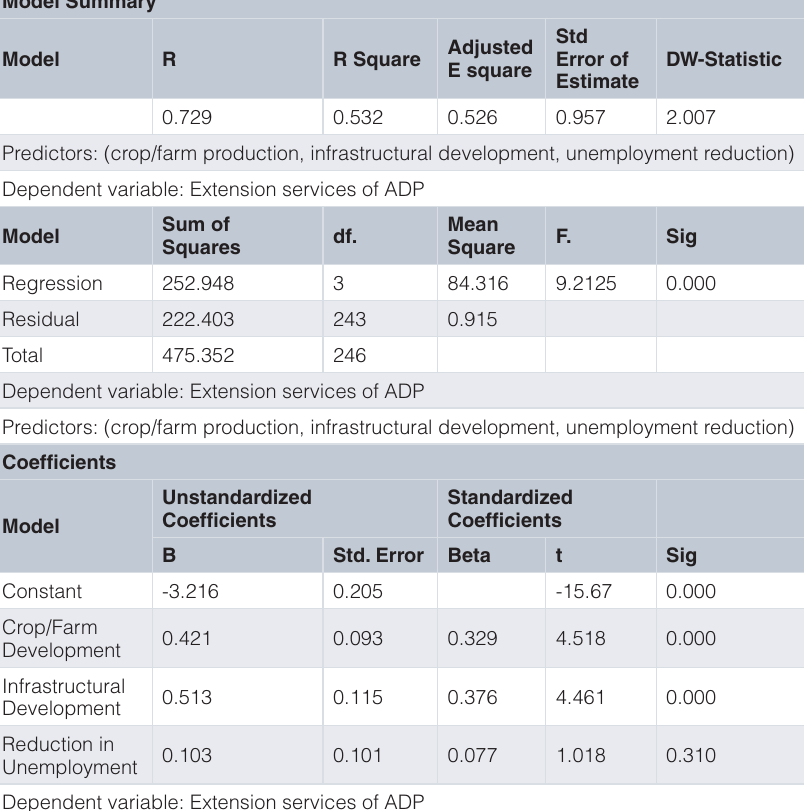
Table 8. Extension services of ADP and crop/Farm and infrastructural Development and unemployment Reduction. Model